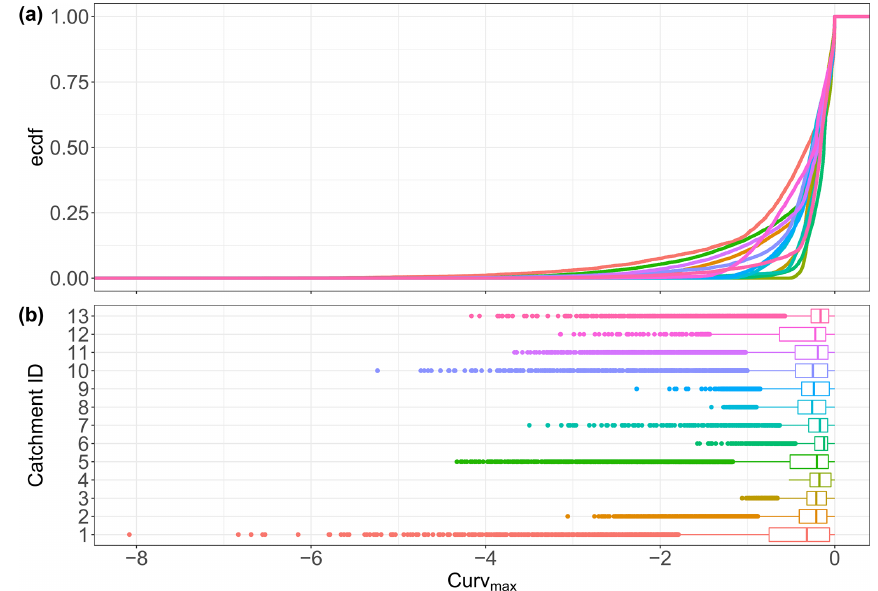
Figure B5. Curv max distributions resulting from running the same 11107 input parameter combinations in each of the 13 catchments. Panel (a) shows the elemental cumulative distribution and (b) boxplots. None of the catchments have a normally distributed Curv max set according to the Kruskal–Wallis ( p < 0 . 05) test.